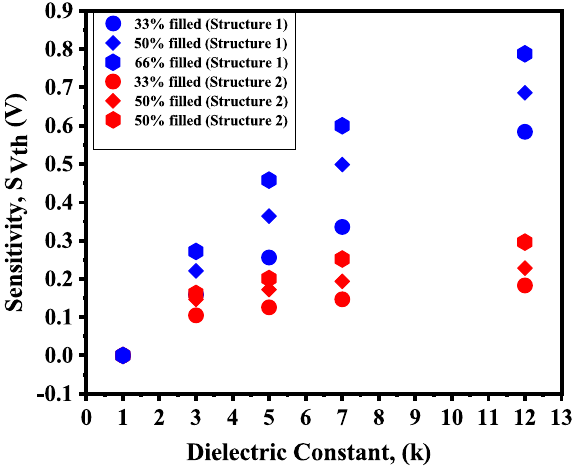
Figure 14. Sensitivity of the proposed DM-DG-TMD-FET-based biosensor when the cavity is partially filled with biomolecules ( V gs = 1.2 V , V ds = 0.1 V ).